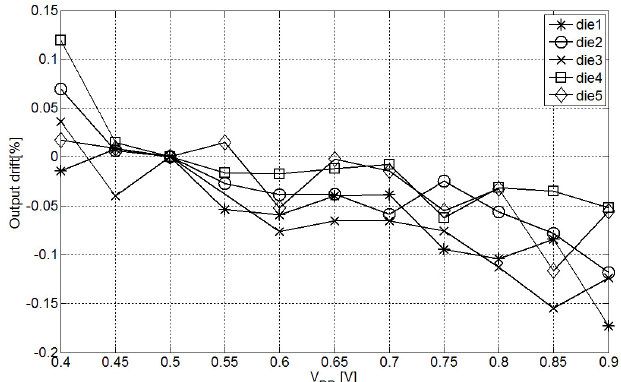
Figure 8. Supply voltage variation effect in the output